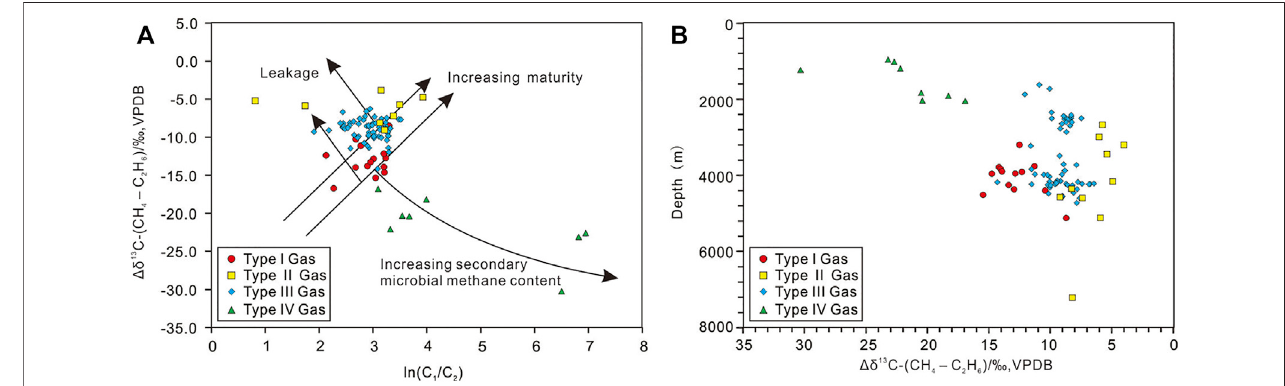
FIGURE11| BiomarkercharacteristicsofcrudeoilassociatedwithType IV gas in Well L103. (A) TIC; (B) m/z 177; (C) m/z 191.